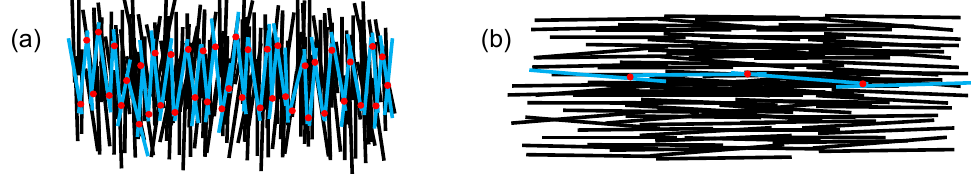
Figure 13. Two simplified scenarios for an electron path from left to right with a fiber orientation ( a ) transverse and ( b ) along the main current direction. The carbon fibers are marked in black, the selected electron path is highlighted in blue and the fiber contact points along the path are marked as red dots.